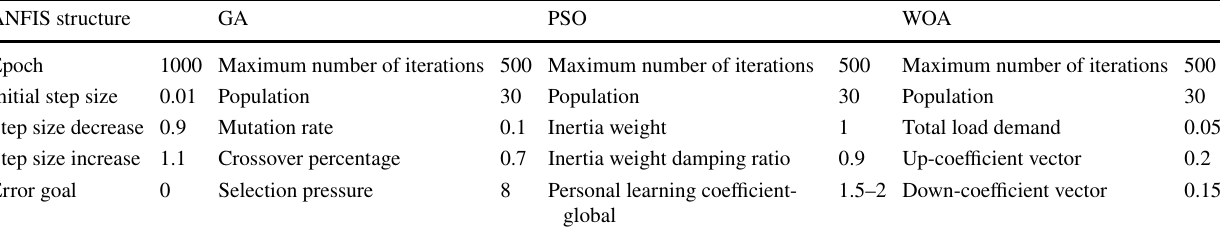
Table 4 Models’ parameters ANFIS